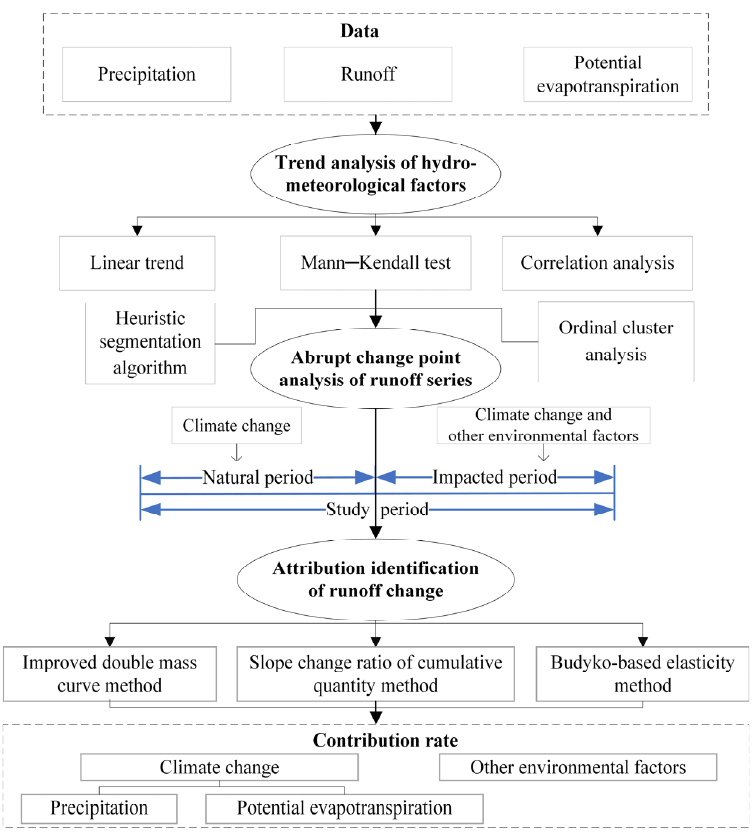
Figure 1. Flowchart of quantifying the contribution of various factors to runoff variation in the SRYZ and SRYR. and